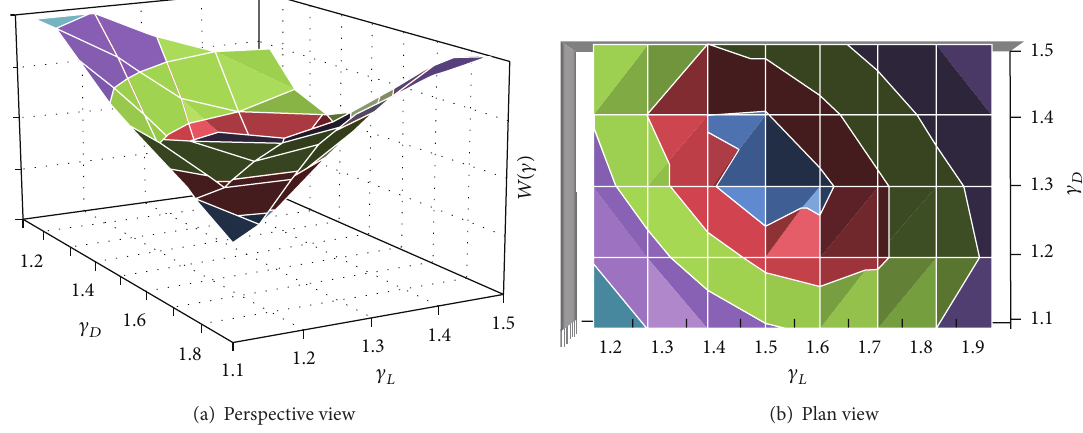
Figure 14: Calculation of optimal load factors.